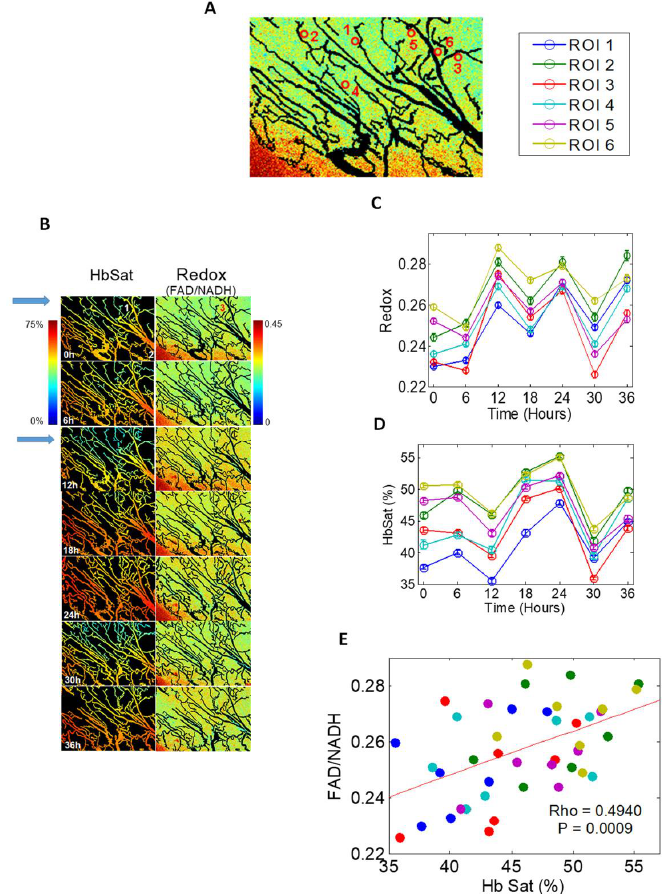
Figure 1. Window chamber data illustrating relatively slow fluctuations in tumor oxygenation and redox ratio. In this study, nude mice with window chambers were transplanted with FaDu head and neck cancer cells. After several days of growth, hemoglobin saturation Hb sat and redox ratio (ratio of fluorescence intensities of FAD and NADH) were measured every 6 h for 36 h. ( A ) Regions of interest selected for analysis. ( B ) Paired Hb sat and Redox ratios from one tumor. Note particularly the region indicated by the blue arrow at 0 and 12h. This region shows fluctuation in both parameters